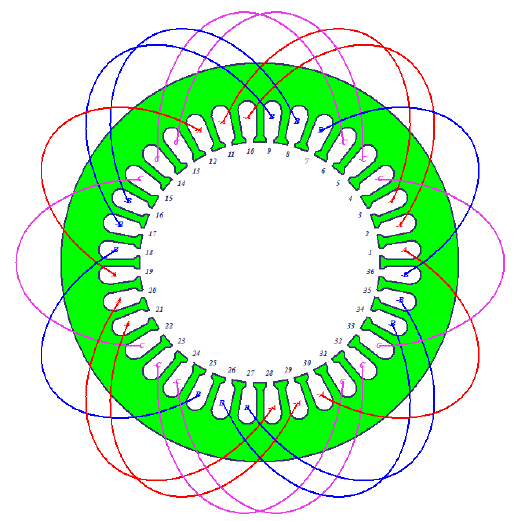
Figure 1. Arrangement and distribution diagram of three-phase windings. (3) The rotor was set with outer diameter of 168.7 mm, inner diameter of 60 mm, length of rotor core of 190 mm, material of DW315_50, number of rotor slots of 32, effective magnetic length coefficient in superposition factor field as the default value of 0.95, and with the surface-mounted magnetic pole type.